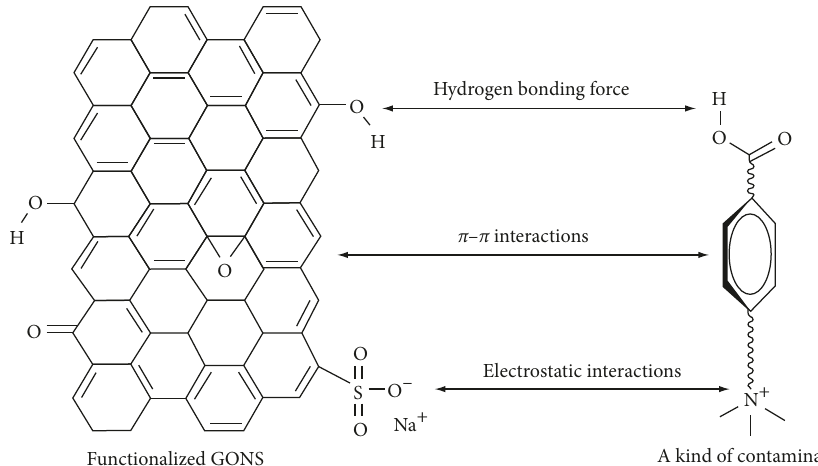
Figure 7: Schematic representation of possible interactions between GONSs and pollutants [66].